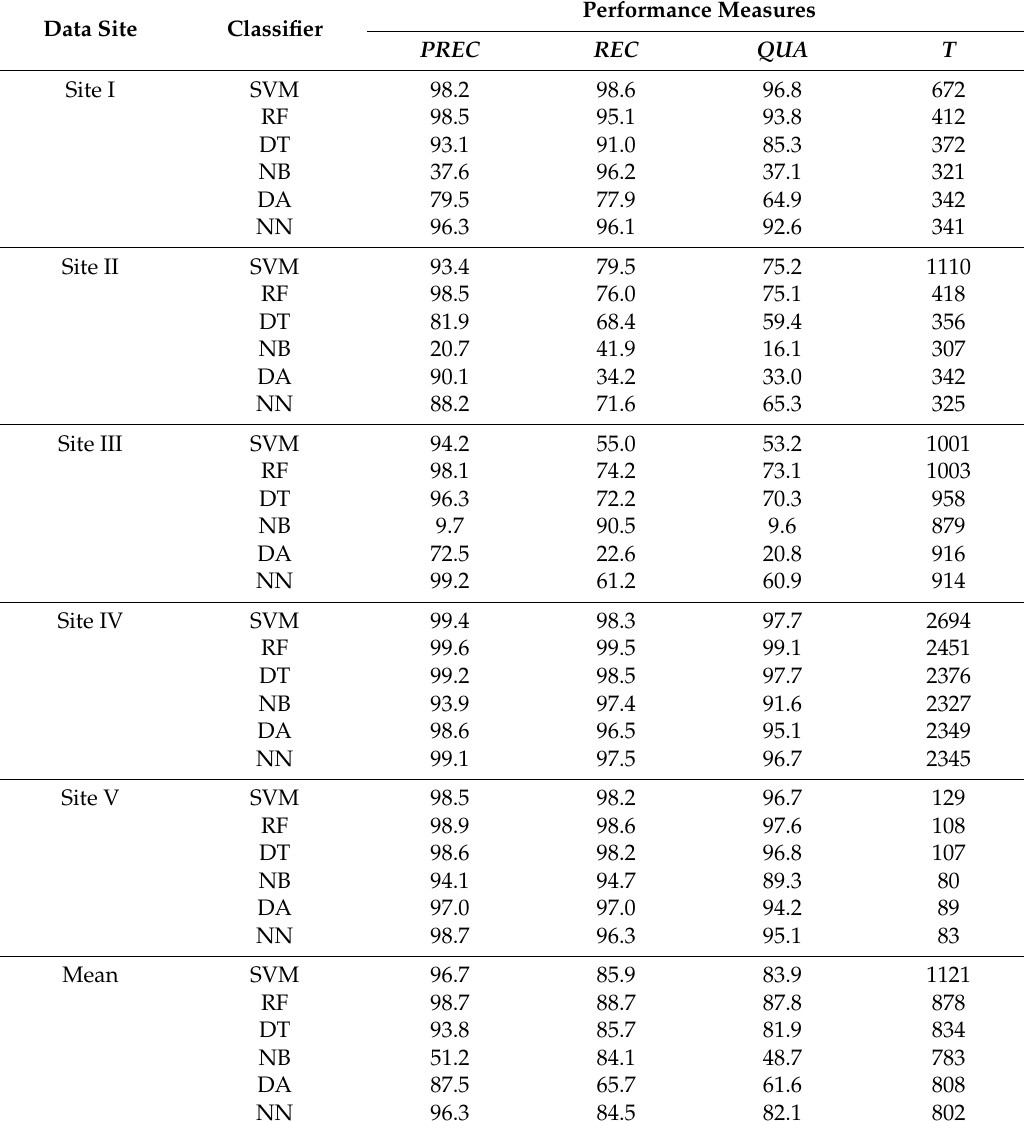
Table 4. Classification performance for six different classifiers ( PREC = precision rate in %, REC = recall rate in %, QUA = quality rate in %, T = processing time in seconds, SVM = support vector machines, RF = random forest, DT = decision tree, NB = Naïve Bayes, DA = discriminant analysis, and NN = neural